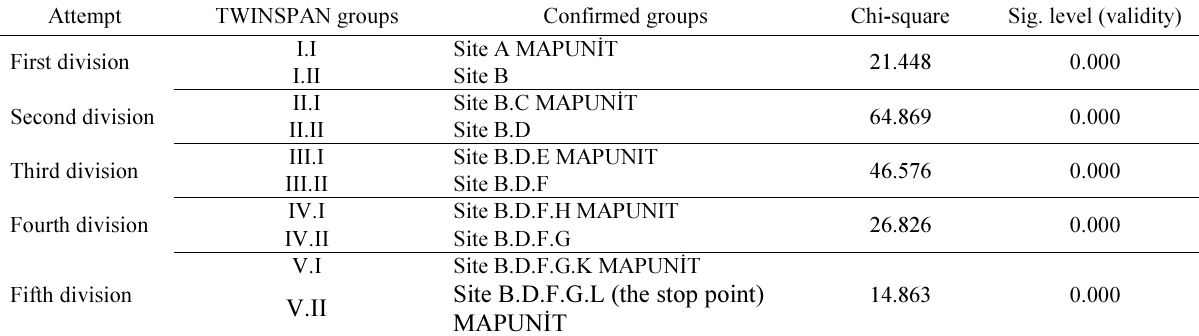
Table 3. Outputs of chi-square tests in TWINSPAN groups and determined